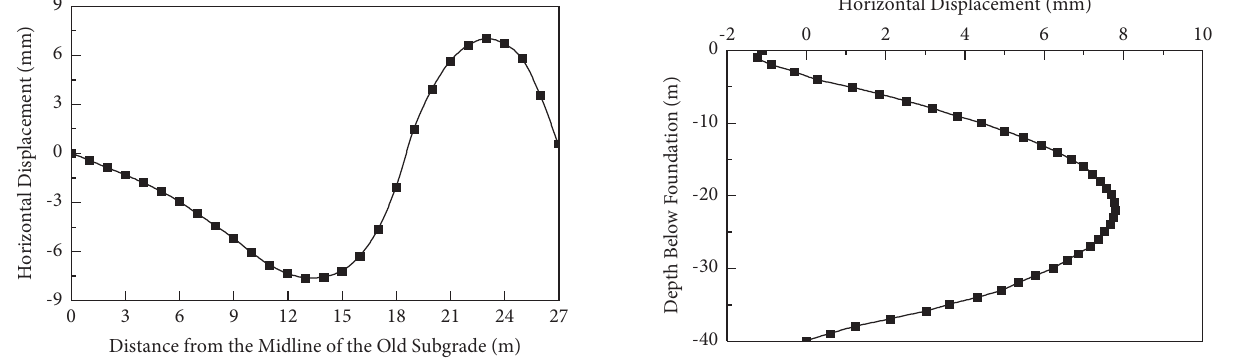
Figure 7: Horizontal displacement of ground surface.